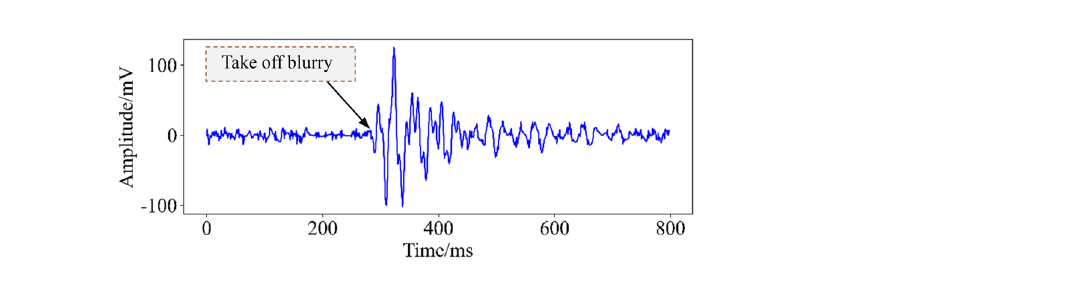
Figure 2. Waveform take-off